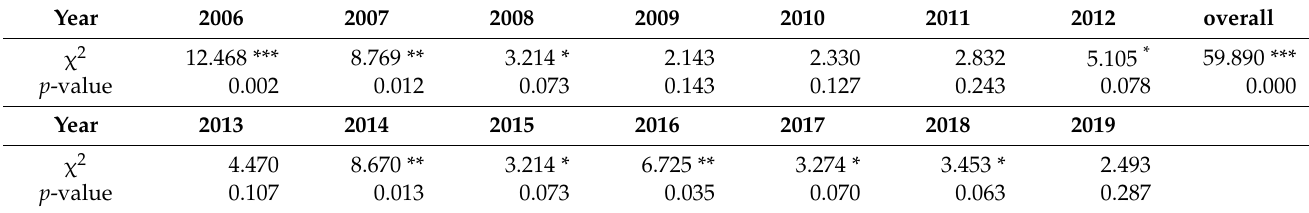
Table 9. The results of Chi-Square